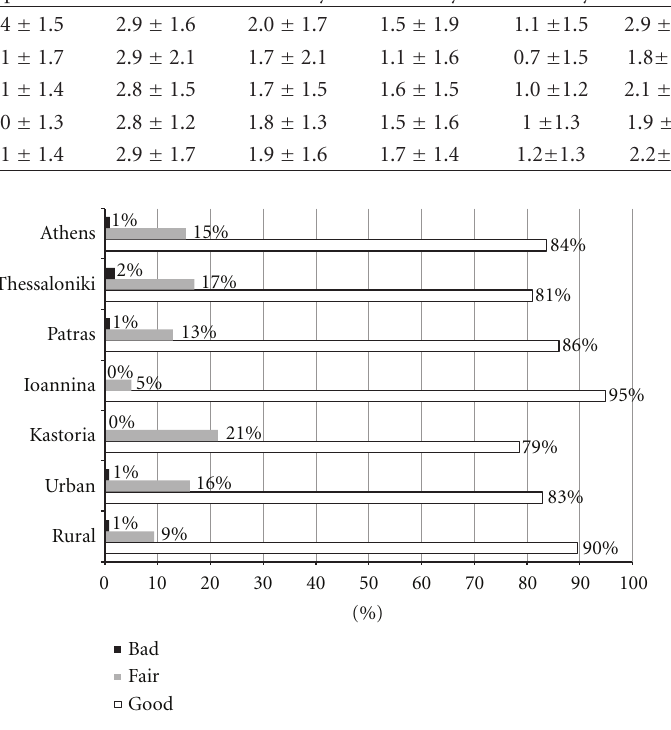
Figure 3: Proportion of responses to the question “How would you judge your general health?”.